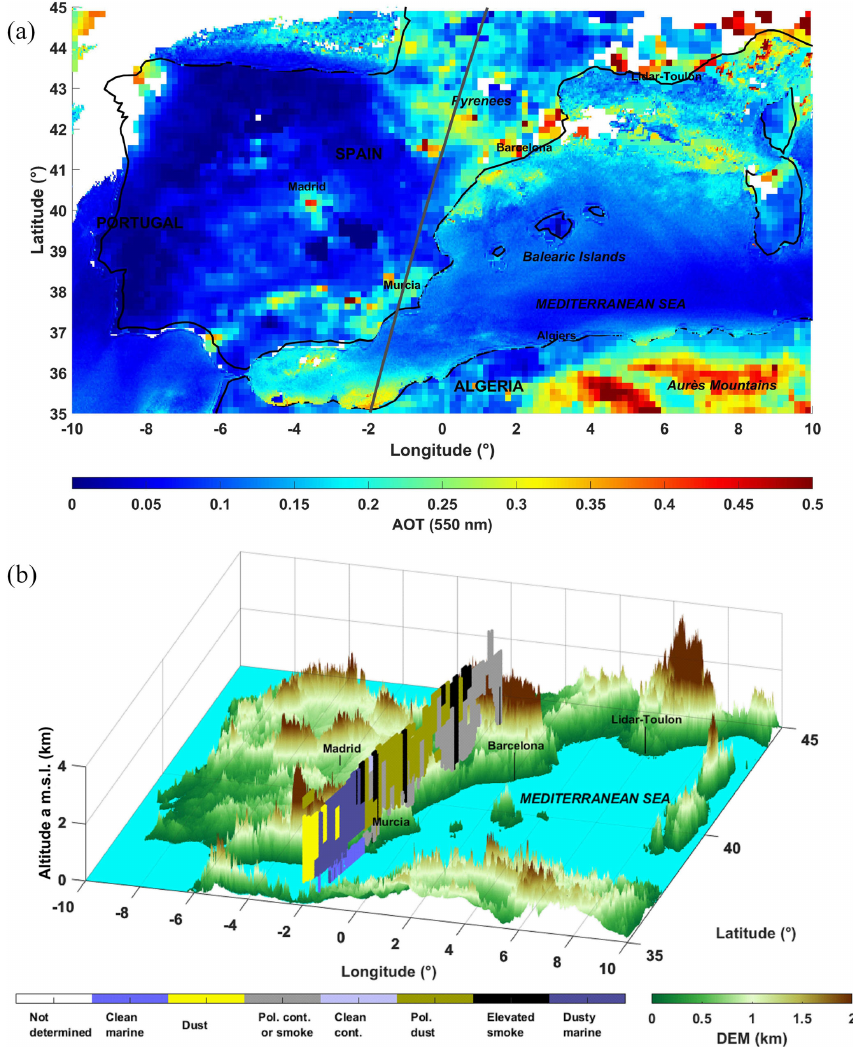
Figure 12. (a) AOT at 550nm derived from the composition of MODIS over land and SEVIRI over sea observations on 25 August 2014. The nearest nighttime ( ∼ 02:15UTC) ground tracks of CALIOP are given as dark grey continuous lines. (b) CALIOP-derived aerosol typing (version 4.10) as observed on August 2014. DEM: digital elevation